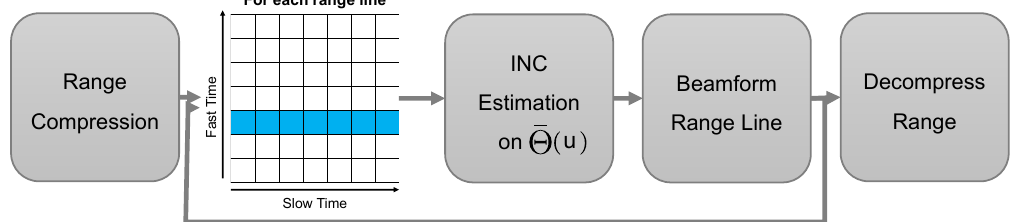
Figure 8. Range-Dependent Time MVDR RFI mitigation with DBF. A mitigation of N − 1 interferers per range line u is